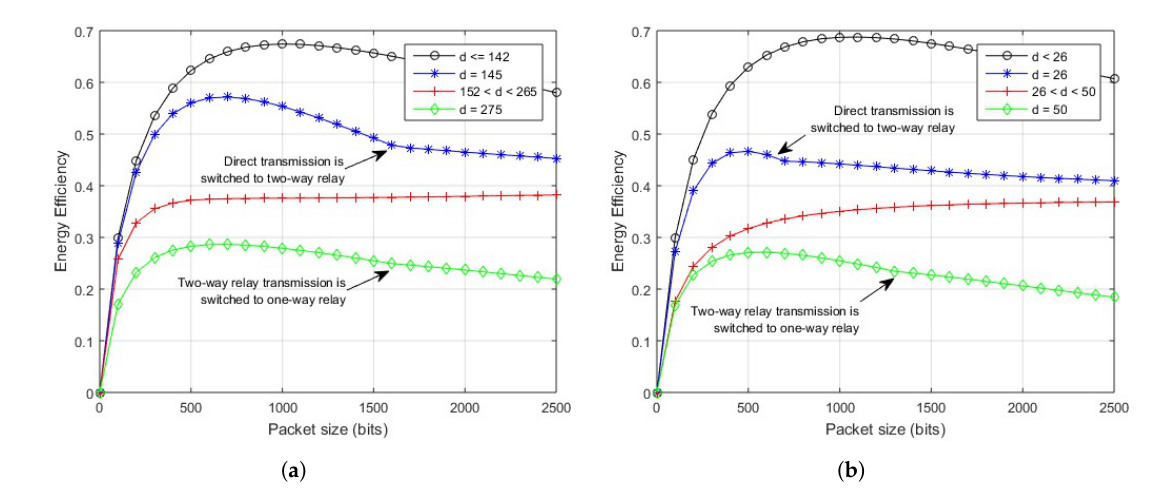
Figure 11. Energy efficiency vs. packet size for the proposed scheme (on-body communication). ( a ) energy efficiency vs. packet size for proposed scheme (on-body LOS communication); ( b ) energy efficiency vs. packet size for proposed scheme (on-body NLOS